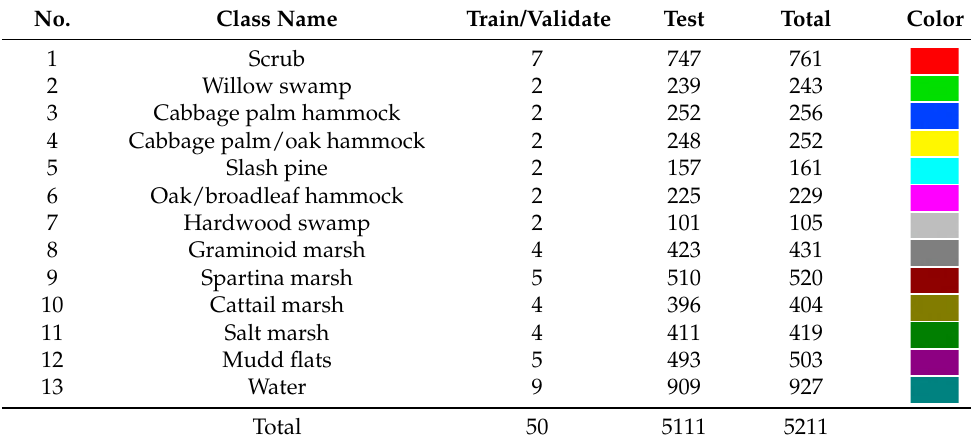
Table 3. The training and testing sample numbers and colors of the KSC